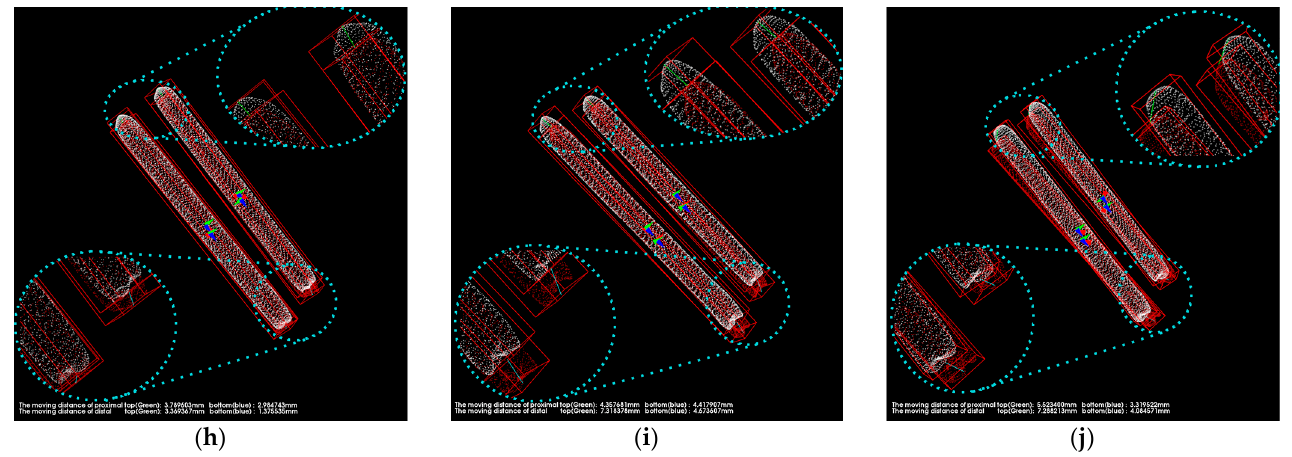
( h ) ( i ) ( j ) Figure 17. The results of the calculation of the pins’ migration. ( a – j ) are the point clouds of pins transformed to the same coordinate system for each of the 10 cases, respectively. The white point cloud is generated based on the postoperative CT images. The red point cloud is transformed form the point cloud generated based on the CT images scanned after one year. Table 5. Result of relative angles and movement of the pins.